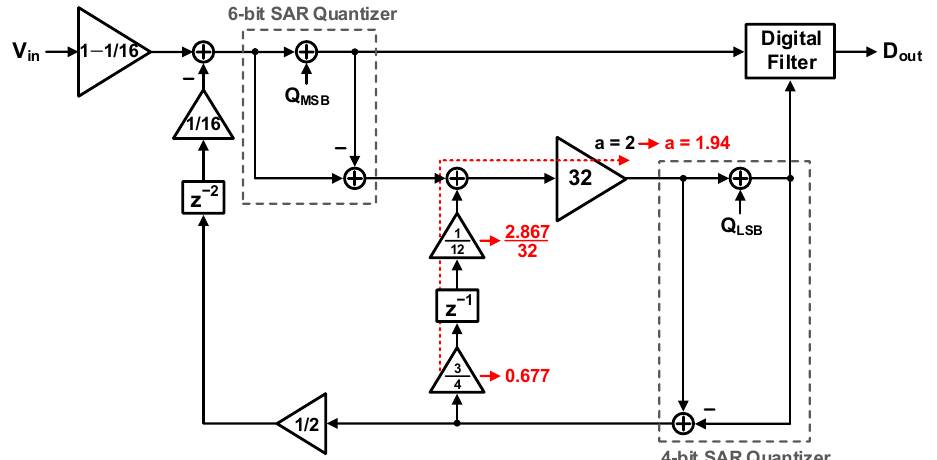
Figure 3. Block diagram for practical circuit implementation.